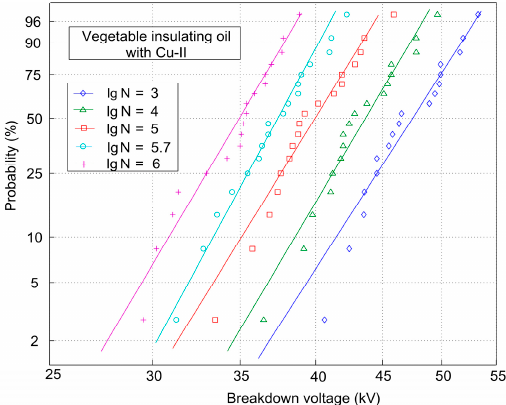
Figure 4. Weibull probability plot of AC breakdown voltage of vegetable insulating oil contaminated with Cu-II. Table 3. Breakdown voltage of vegetable oil contaminated with Cu-II of different numbers.